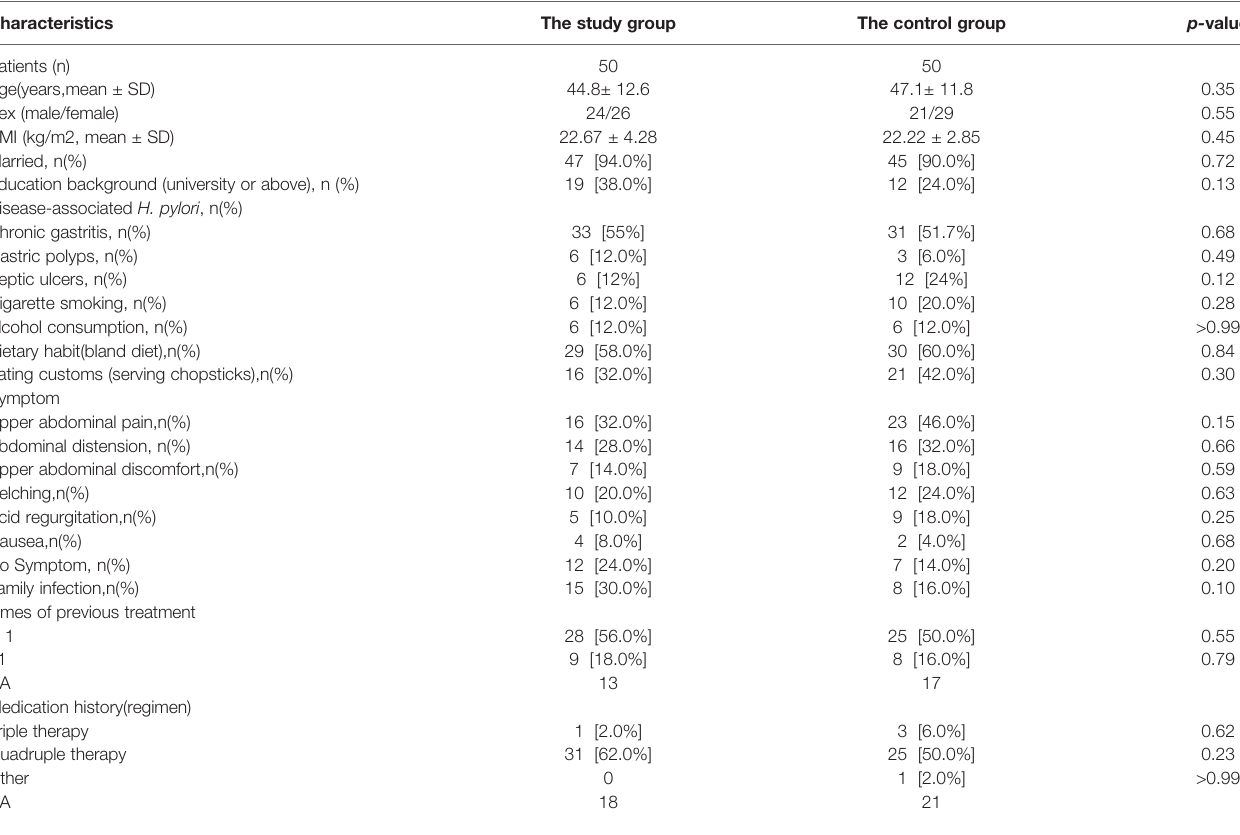
TABLE 1 | Demographic characteristics of patients in the fi rst stage of rescue therapy.